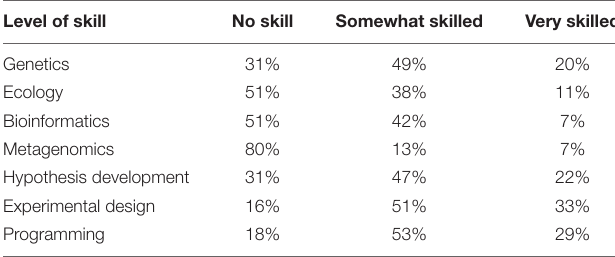
TABLE 1 | Student self-reported knowledge and skills ( n =